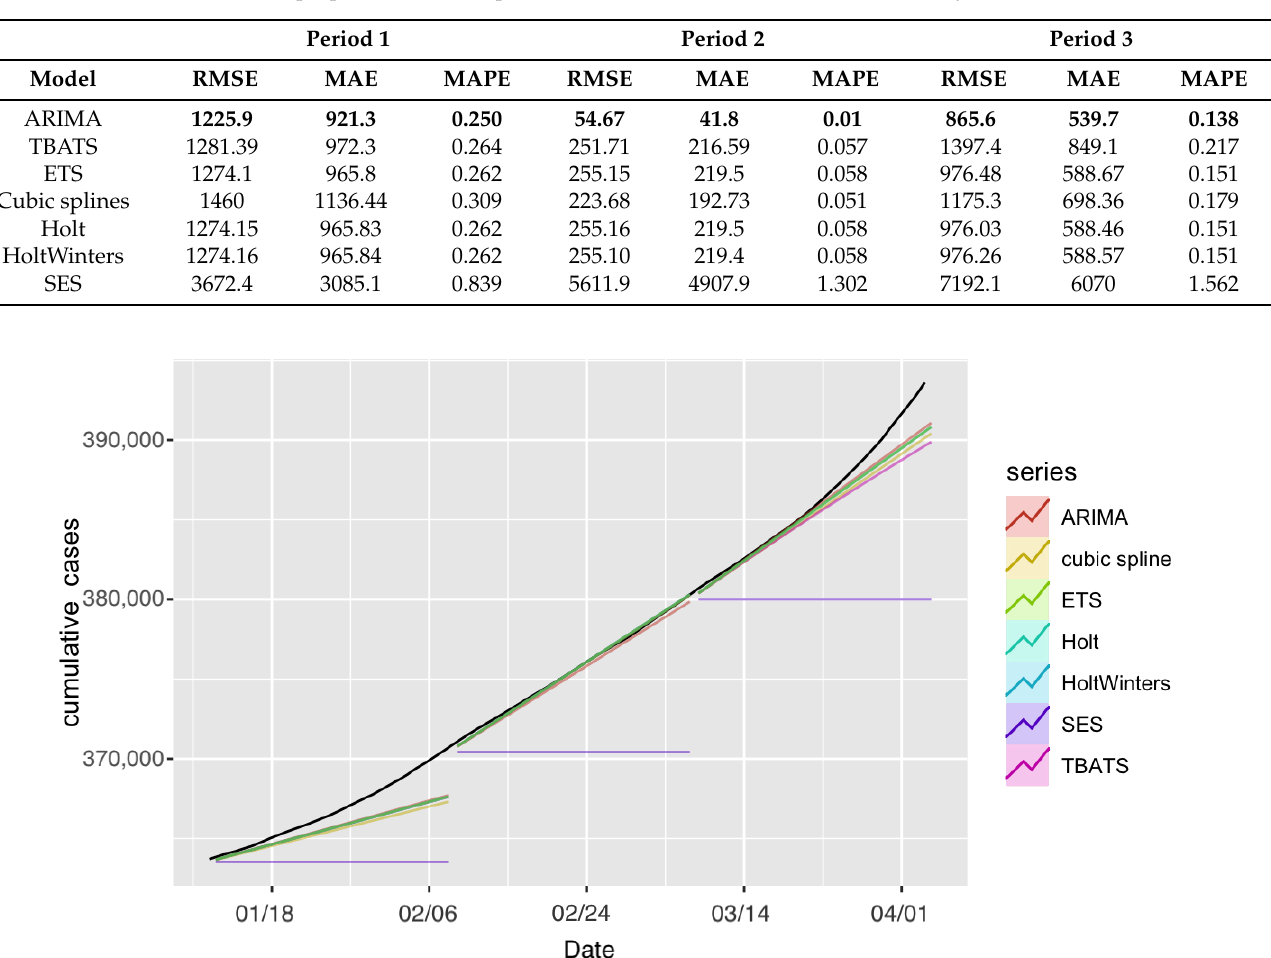
Figure 2. Forecast confirmed cases in Saudi Arabia projected under each model and forecasting period. The black line represents observed confirmed